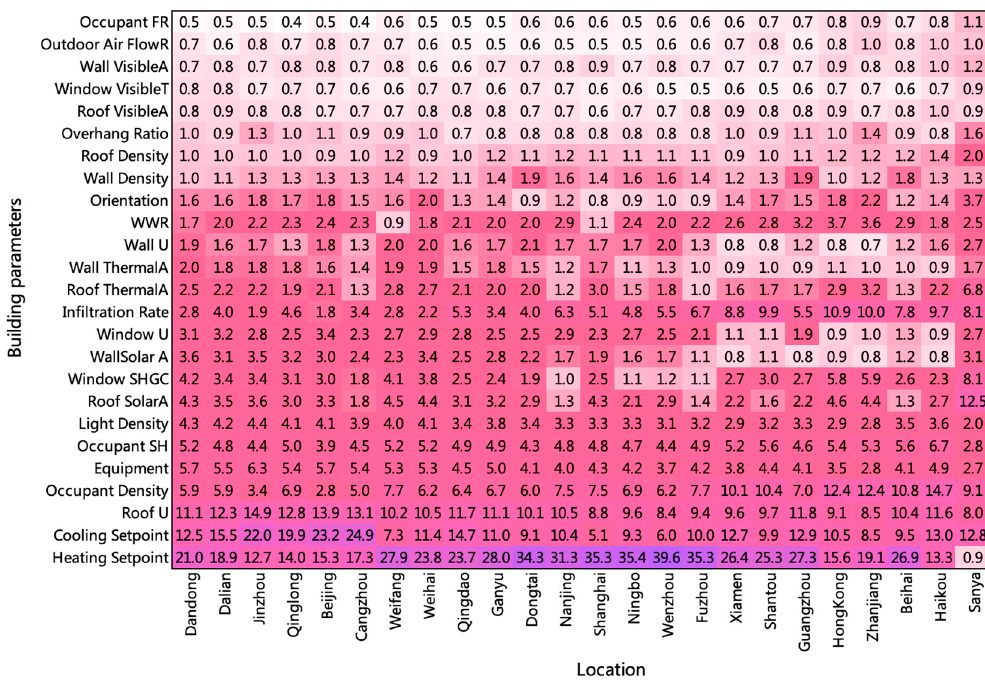
Figure 8. PI of input parameters in IUH.